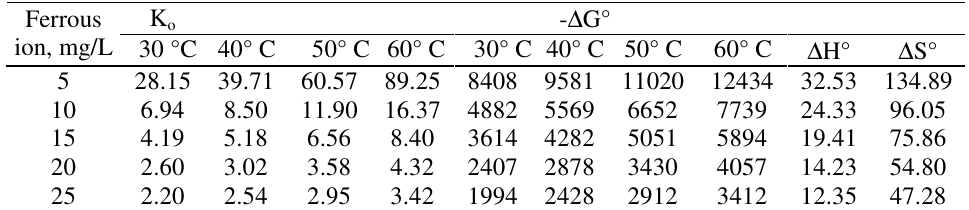
Table 6. Equilibrium constant and thermodynamic parameters for the adsorption of metal ions onto acid activated carbon Temperature,